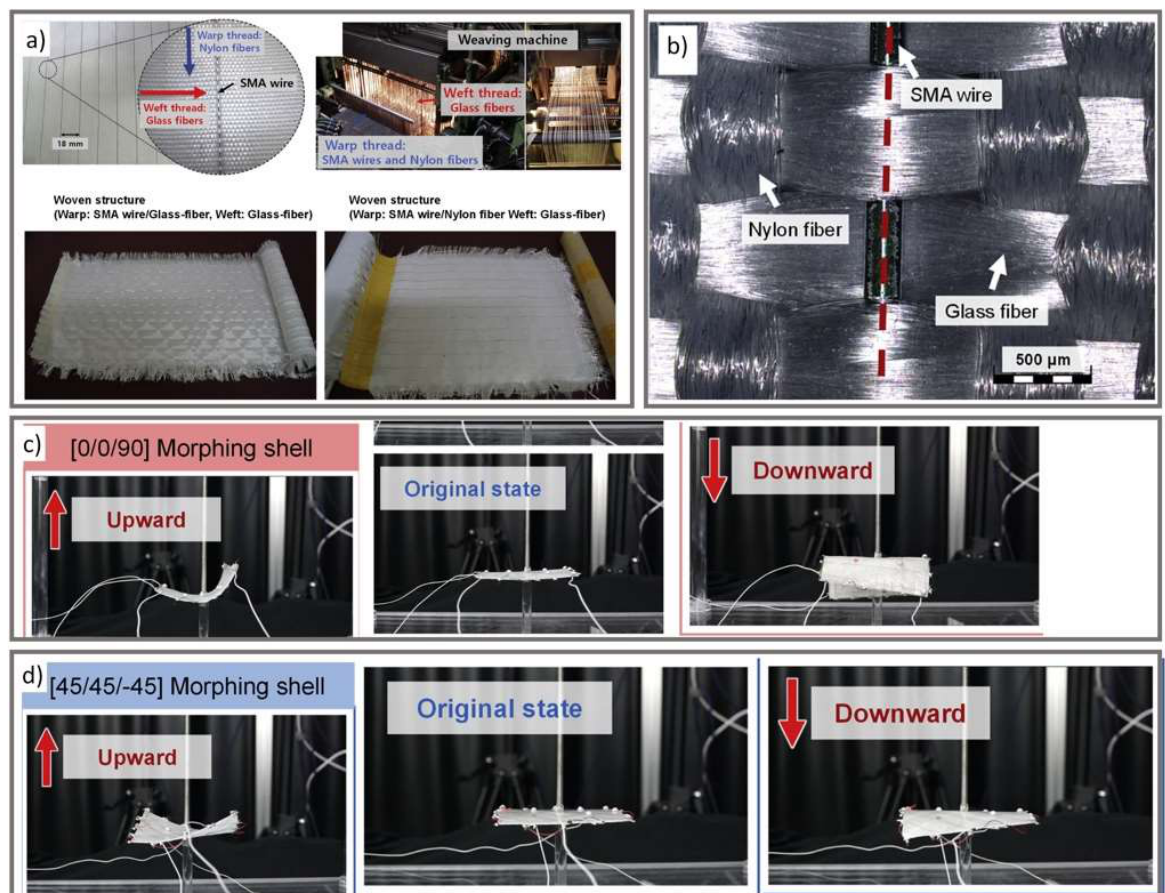
Figure 7. ( a ) The fabrication process of shape memory alloy (SMA) textile containing SMA wires, nylon, and glass fibers. ( b ) A closer look at the SMA woven textile. ( c , d ) Pictures of a morphing shape memory textile composite prepared with [0/0/90] and [45/45/ − 45] laminates in the original state and well as in upward and downward positions (reprinted from [57] with permission from Elsevier).